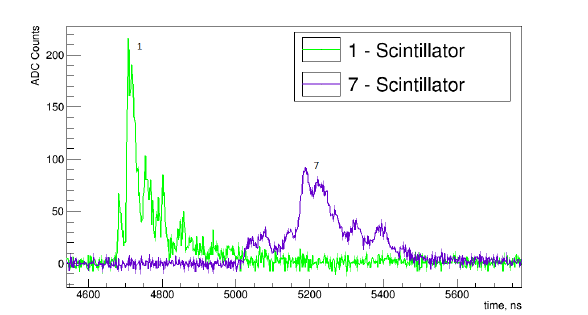
Figure 2. Arrival times at di ff erent distances from EAS axis at the observation level.